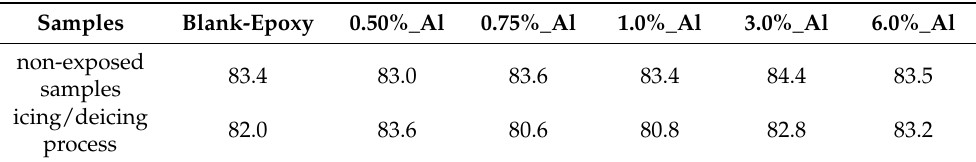
Table 4. Results of coating hardness testing for epoxy matrix with and without adding Al NPs before and after the icing/deicing process.